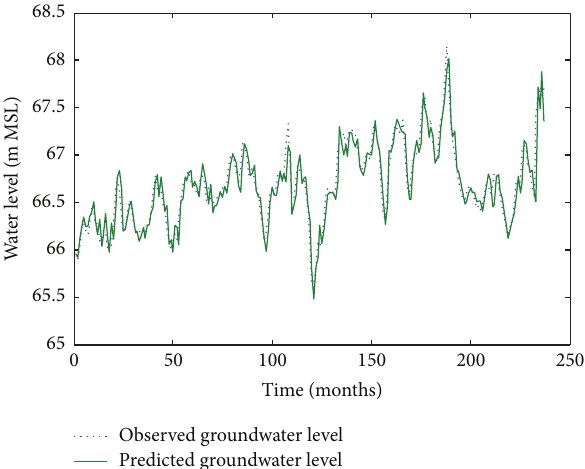
Figure 12: Comparison of observed groundwater levels with simu- lated results for 1 month ahead using an ANFIS model (Pp 930).